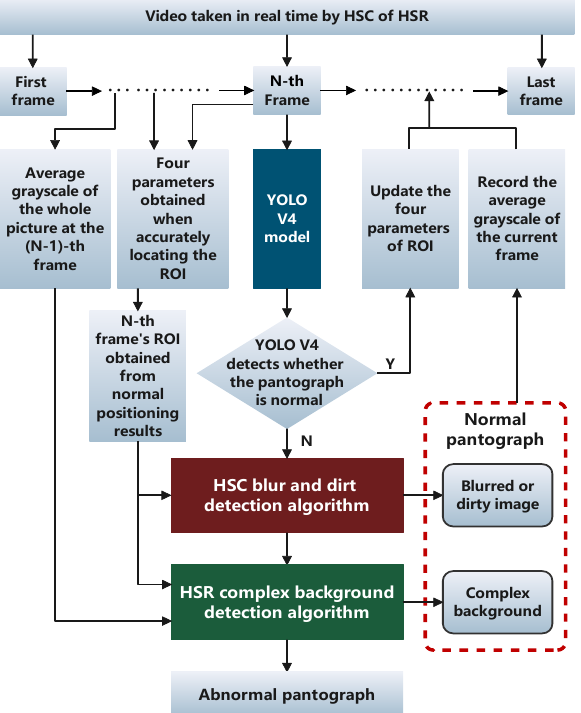
Figure 27. pantograph detection algorithm process flow